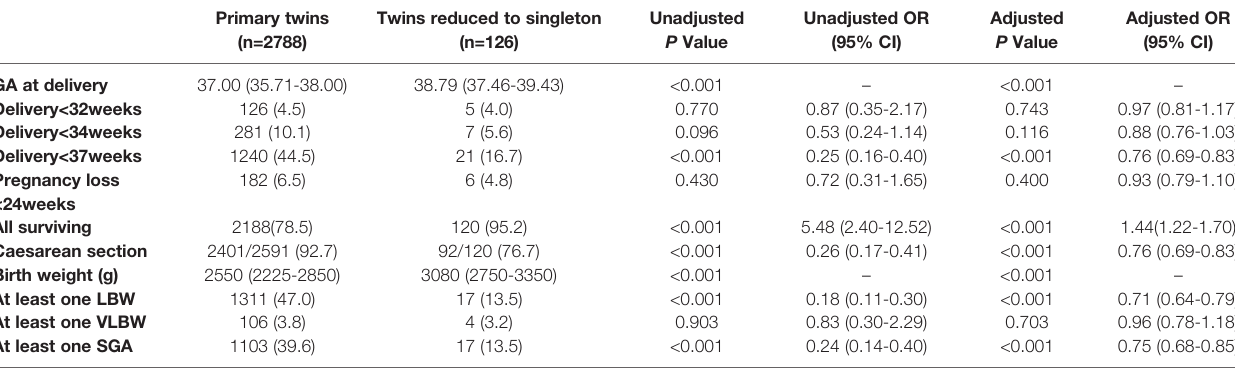
TABLE 3 | Pregnancy outcomes of twins reduced to singletons versus primary